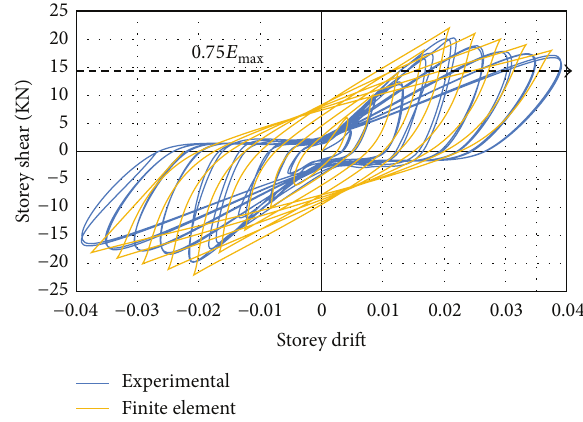
Figure 12: An experimental and finite element hysteresis response comparison for the DCL-DOUBLE